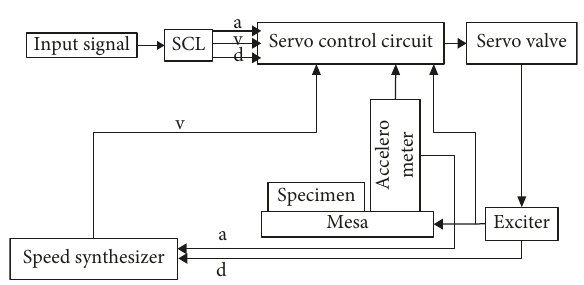
Figure 6: Schematic diagram of three-parameter control system.